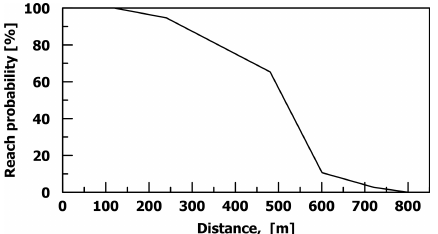
Table 4. Restitution parameters for Rockyfor3D. Geological formation/other material Mean MOH Soil type Scree (Ø < 4 ∼ 10cm), or medium compact soil with small rock fragments Talus slope (Ø > ∼ 10cm), or 0.38 compact soil with large rock fragments Talus with fallen boulders Bedrock with thin weathered material 0.43 Asphalt road 0.35